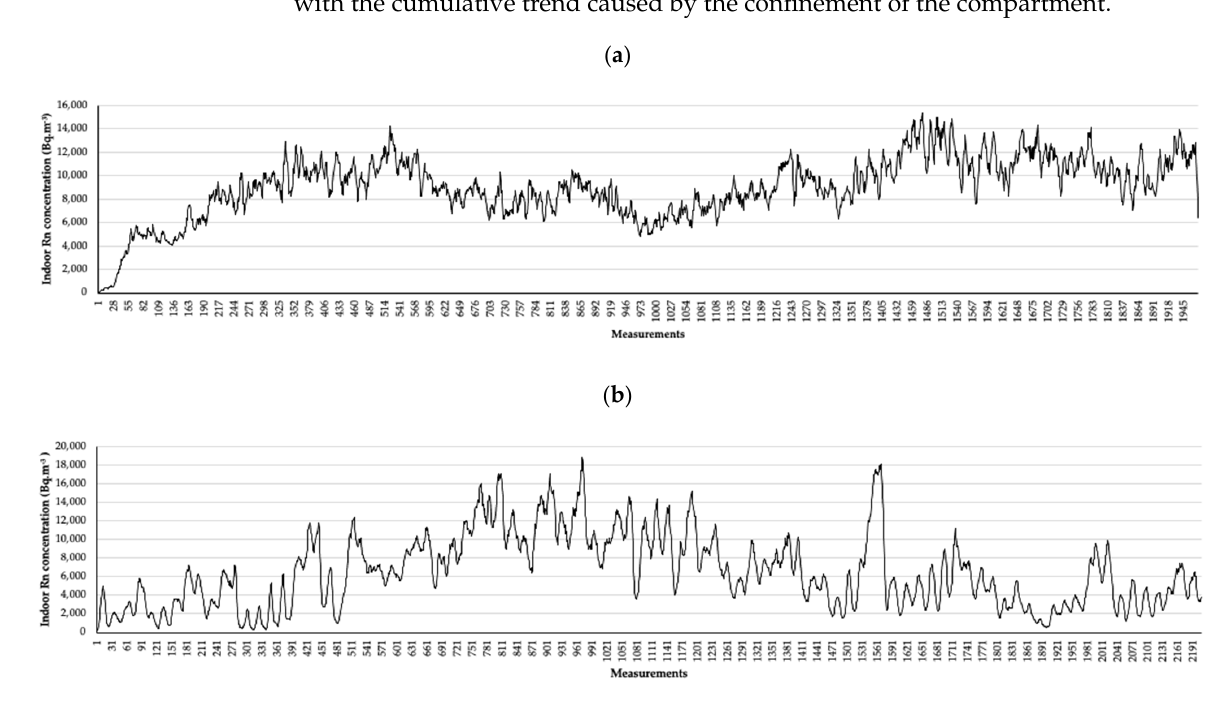
Figure 7. Evolution of indoor Rn concentration measurement results. ( a ) After compartment door sealing; ( b ) results of the preliminary assessment in Phase I.